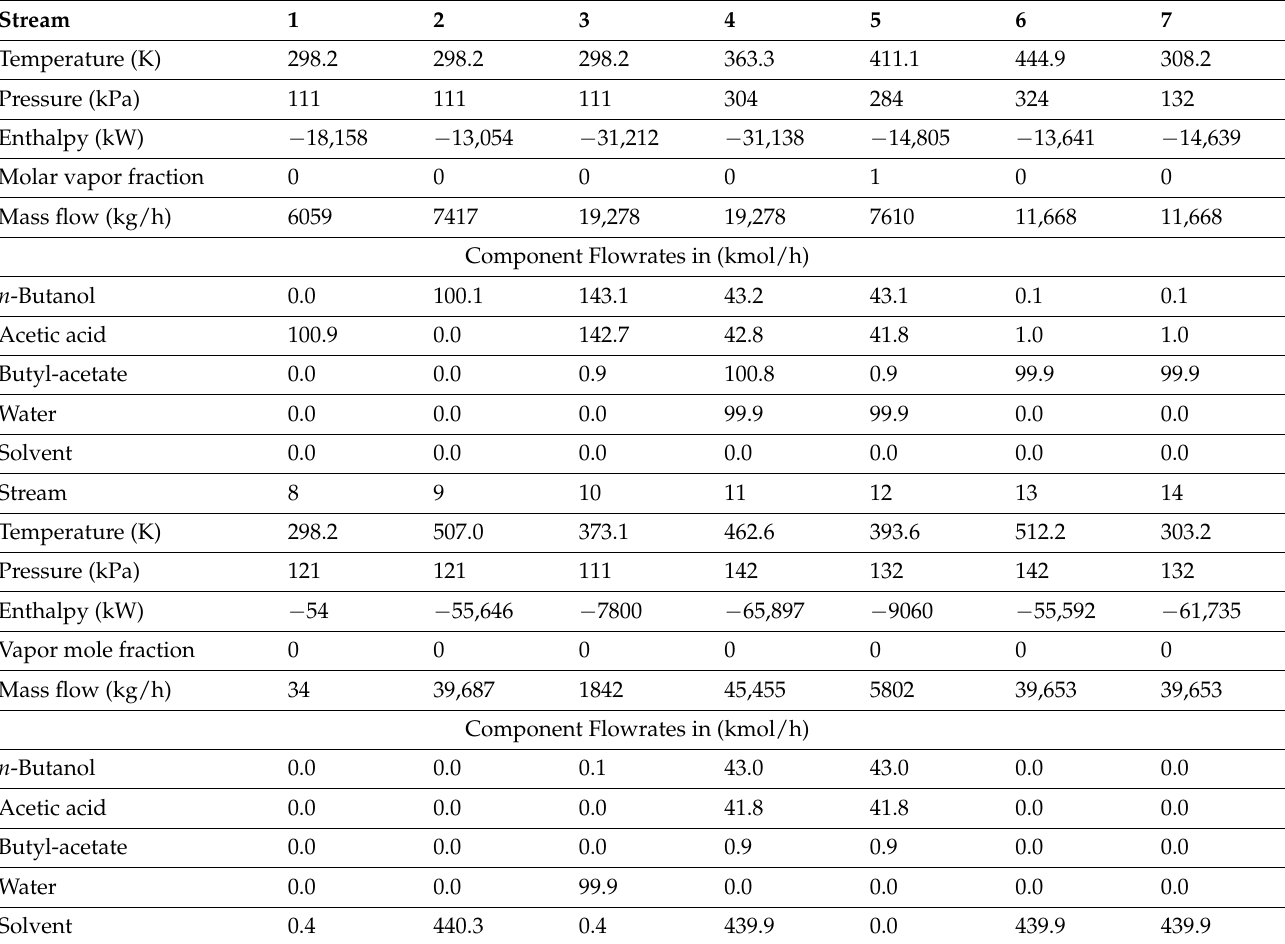
Table 7. Streams information on the conventional process for n -butanol esterification with acetic acid.